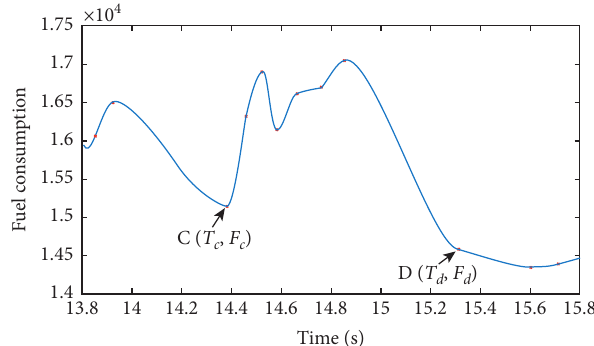
Figure 5: F-T curve in one experiment. The red dot is the simu- lation results, and the blue curve is the shape preserving inter- polation based on the red dot. Figure 4: Illustration of the Pareto